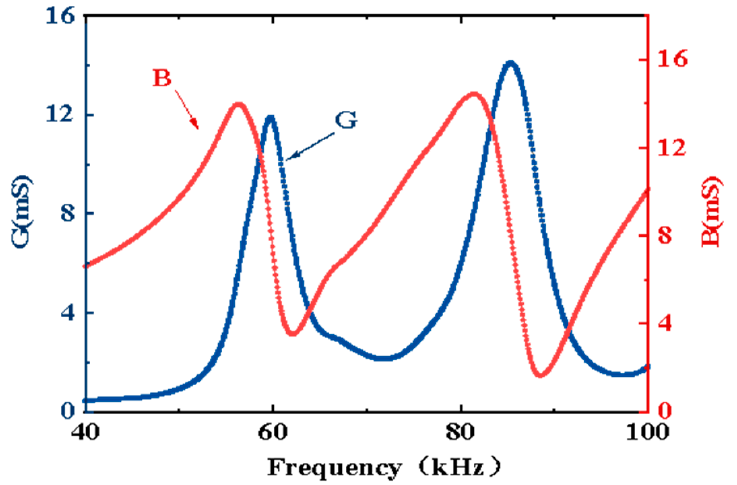
Figure 10. Admittance curves of the transducer array in water. B: Electric-susceptance ; G: Electric-